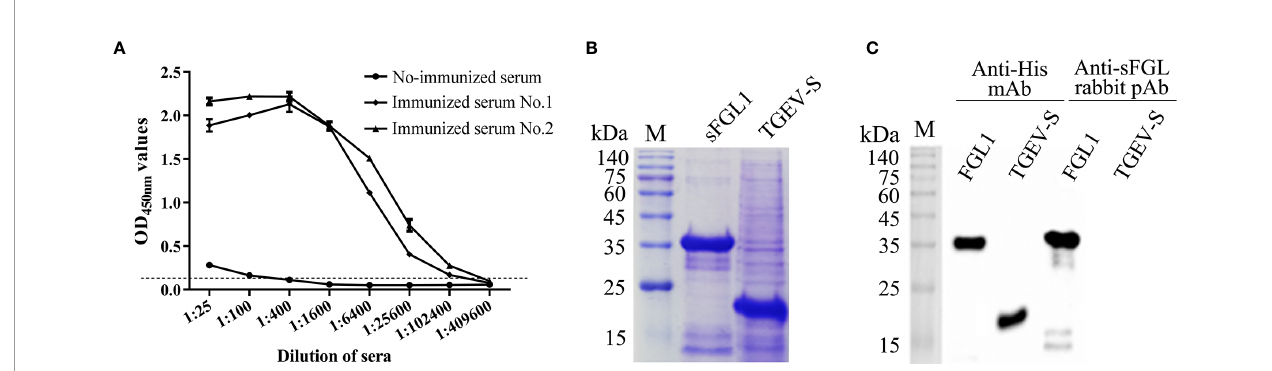
FIGURE 2 | Characteristics of rabbit pAb against sFGL1. (A) Titers of antibody against sFGL1 in the sera of immunized rabbits. (B) Identify expressed sFGL1 and TGEV-S protein by SDS-PAGE and Coomassie brilliant blue staining. The TGEV-S protein was used as a control protein. (C) Identify rabbit pAb against sFGL1 by Western